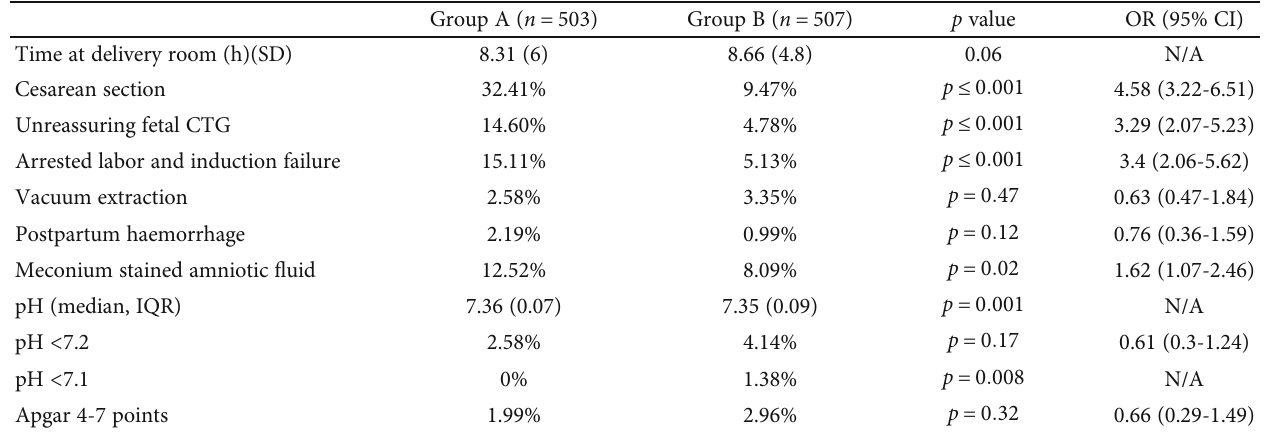
Table 2: Comparison of